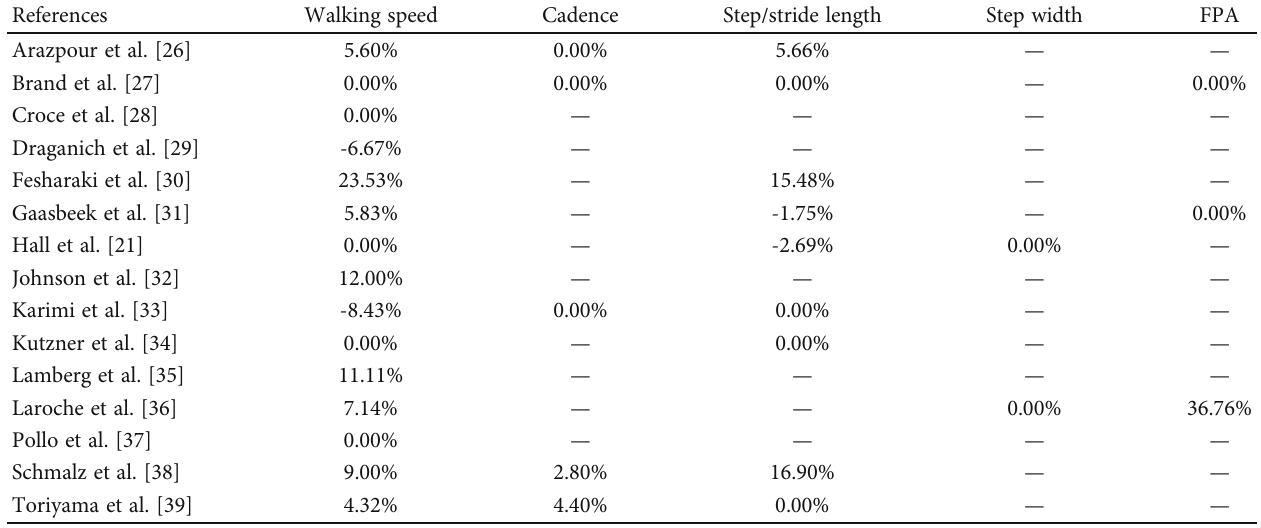
Table 2: The variations of spatiotemporal parameters between braced and unbraced conditions.